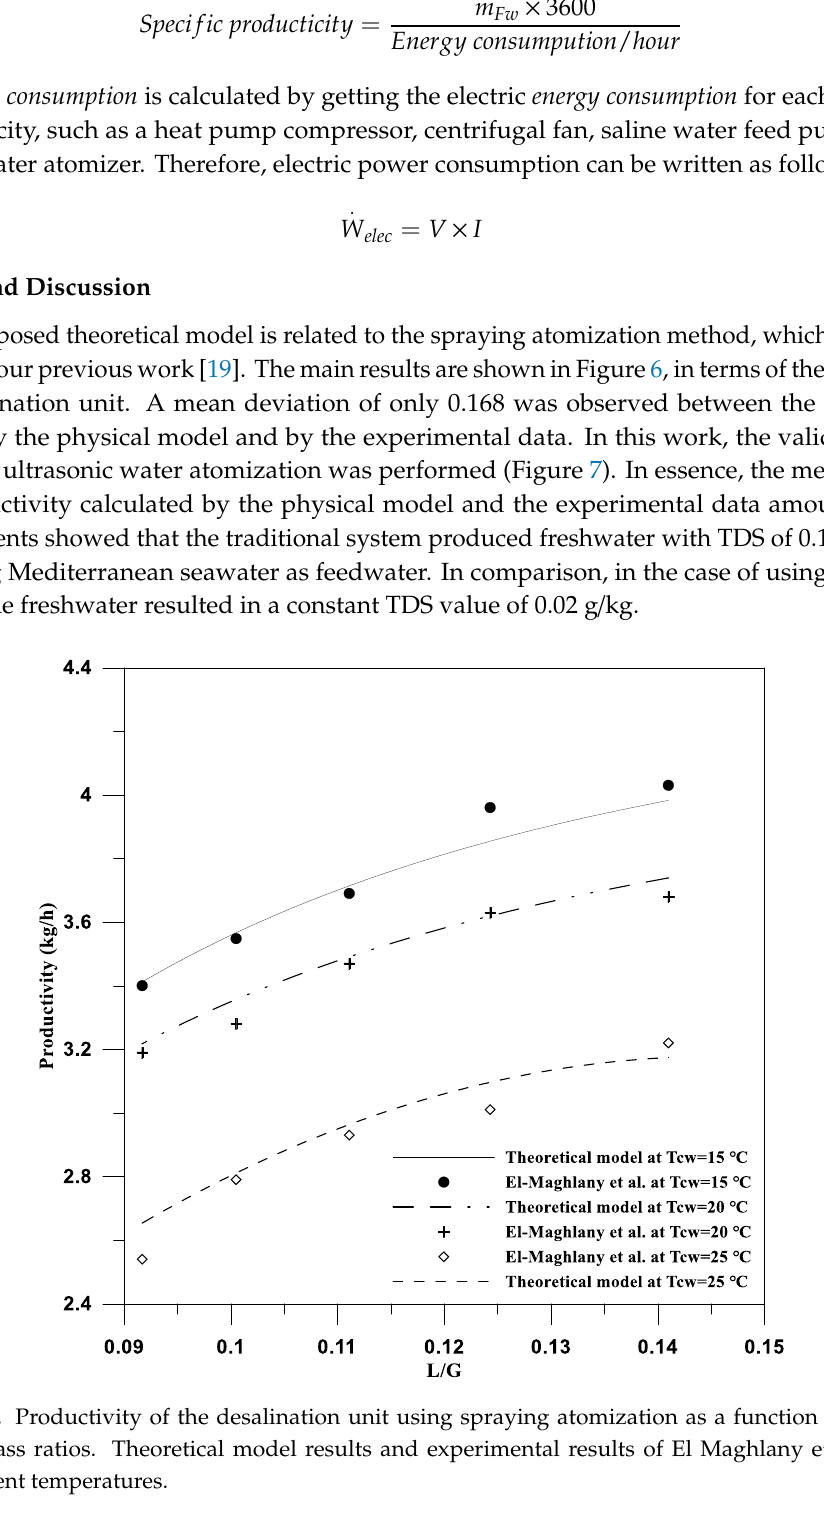
Figure 7. Productivity of the desalination unit using an ultrasonic atomizer system as a function of water to air mass ratios.